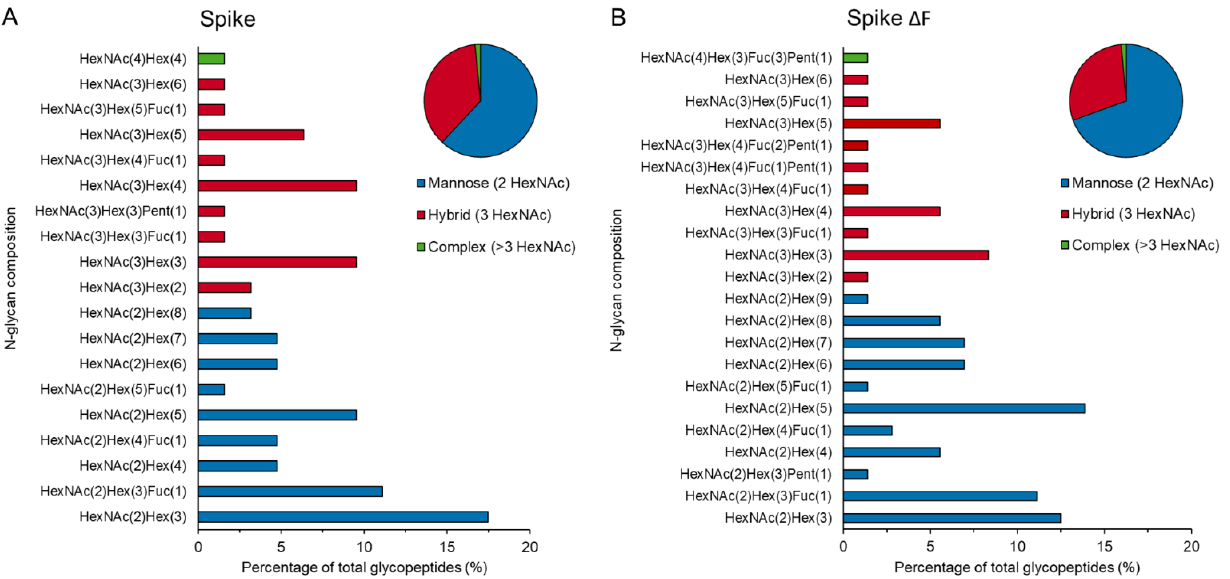
Figure 3. N-glycan composition of the CHIKV spikes with and without furin cleavage site ( ∆ F). Sf21 cells were infected with ( A ) Ac-Spike or ( B ) Ac-Spike ∆ F, secreted spikes were purified from the culture fluid and analyzed for total N-glycan composition using LC–MS/MS-based glycoproteomic analysis. The bar graph provides a detailed description of the detected N-glycans. The pie chart represents a summary of the N-glycan structure types.